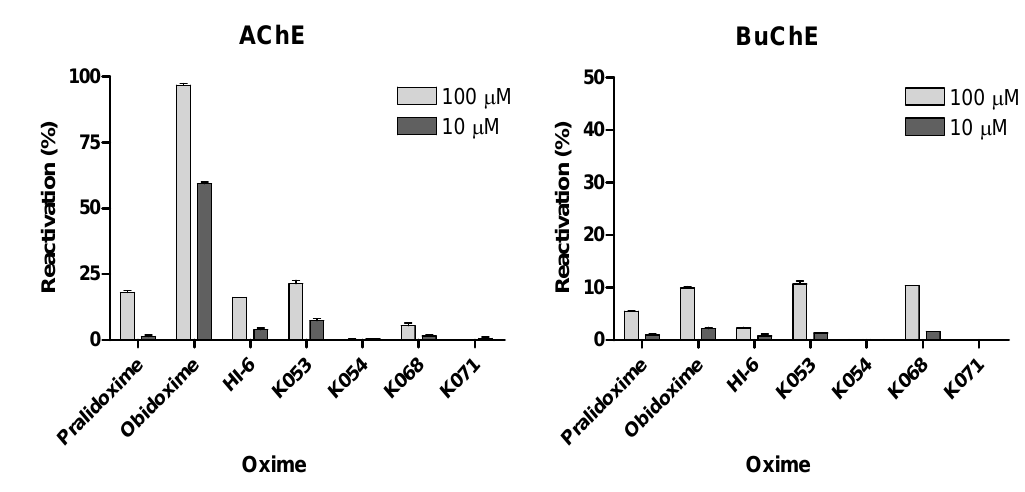
Figure 3. Reactivation of paraoxon-inhibited AChE and BuChE by the novel bisquaternary aldoxime